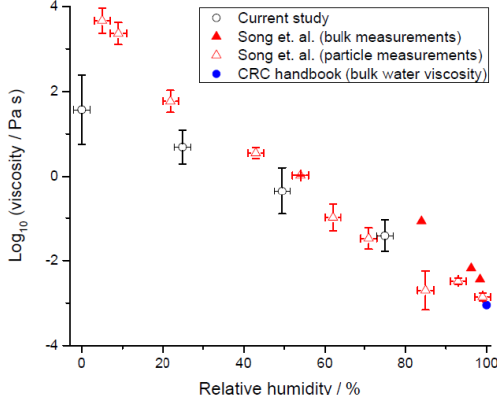
Figure 5. Plot of log 10 (viscosity/Pas) vs. relative humidity for 1,2,3,4-butanetetrol. Experimental data determined here using the bead mobility technique are shown as black circles, with uncertain- ties as 2 σ . Literature values of Song et al. (2016) are shown as red symbols, and the viscosity of water (Haynes, 2015) is shown as a blue